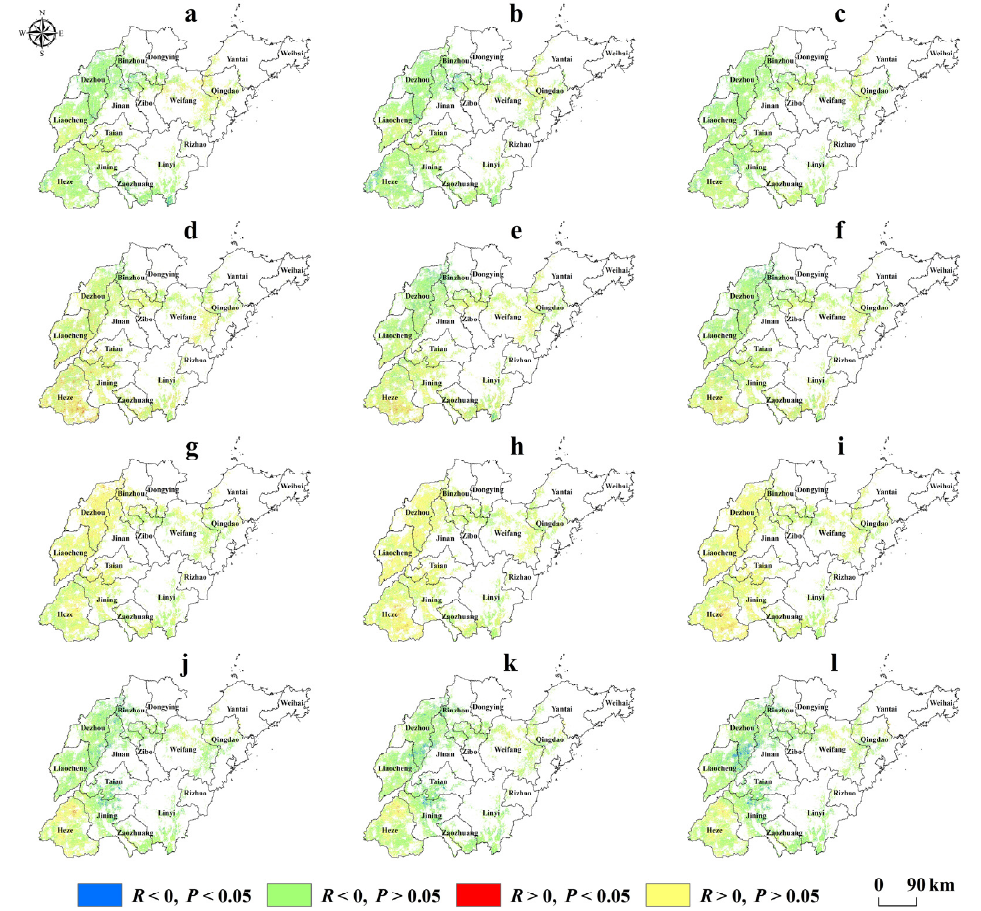
Figure 12. ( a – l ) Same as Figure 9 but for precipitation.